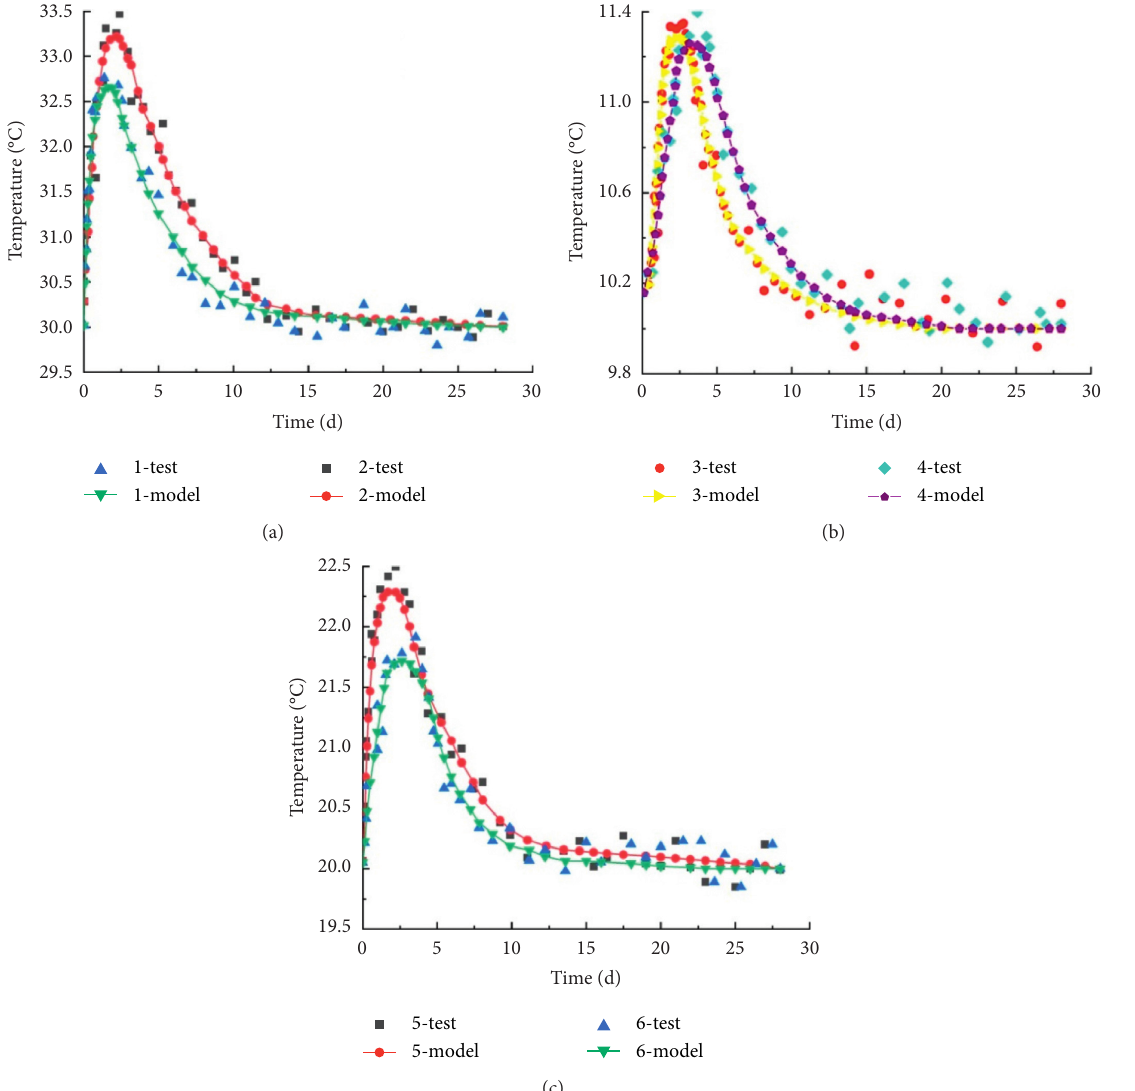
Figure 9: Comparison between predicting and testing results of temperature development in